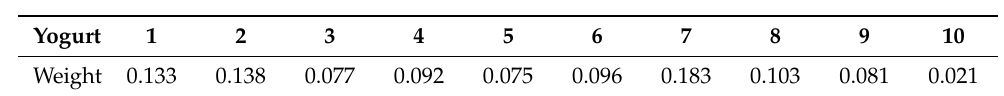
Table A36. Weight of each criterion for